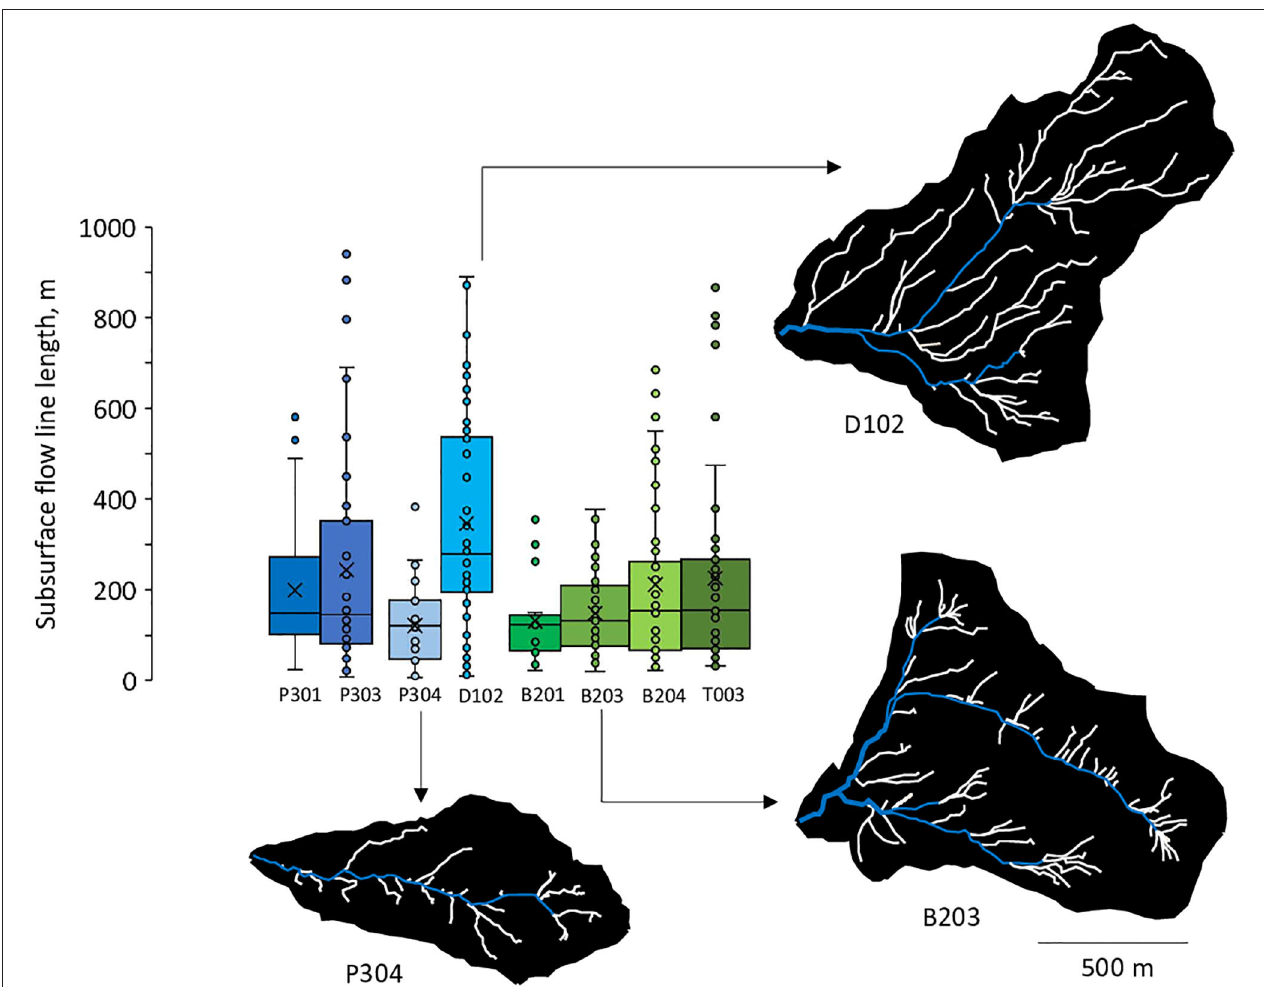
FIGURE 3 | Distribution of the subsurface flow line lengths. Boxes, crosses, vertical lines and points represent interquartile ranges, mean values, variability outside the interquartile ranges and outliers, respectively. The distribution is shown for average hydrologic conditions. River network (in blue) and subsurface flow lines (in white) were determined by the geomorphological study and the delineation of a 1-m DEM. Illustrations are provided for three watersheds: P304, D102, and B203.